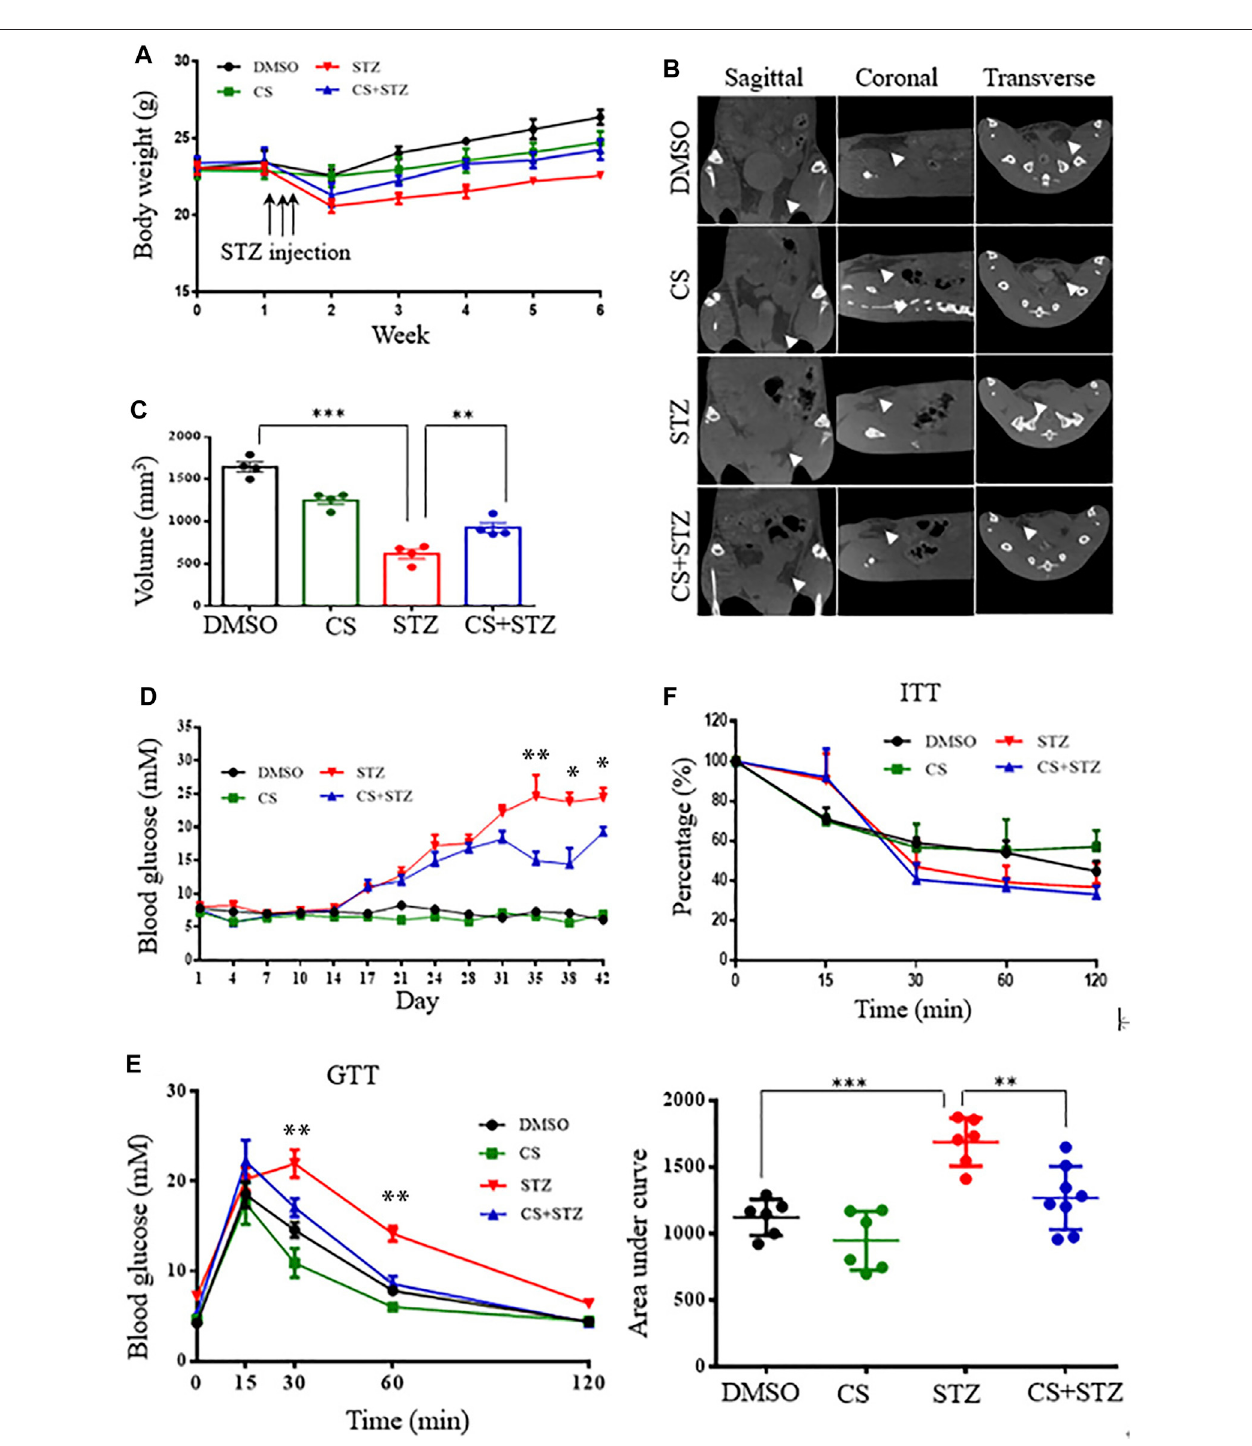
FIGURE2| CSrelievesdiabetesinstreptozotocin(STZ)-treatedmice. Eight-week-old mice weresubcutaneously injected withDMSO orCS(25 mg/kg/dose, two doses daily) for 42 continuous days. Micewere administrated subcutaneously with STZ (40 mg/kg of body weight daily) for four continuous days from the 8th day of the experimental treatment period. (A) Body wight was monitored over time ( n = 7 – 10 mice per group). (B,C) Body fat was measured by micro-computed tomography (B) and adipose tissue volumes between lumbar vertebra one and the caudal vertebra four were compared (C) at the end of the experiment. (D) Blood glucose levels weredeterminedusingaglucometer fromthetailveineverytwootherdays. (E) Glucosetolerancetests(GTT) wereperformedin12-hfastedmice givenintraperitoneally glucose(2 g/kgbodyweight).Plasmaglucoseconcentrationsweremeasuredat thedesignatedtimepoints(leftchart)andtheareasunderthecurve (AUC)ofGTTwere calculated (right chart) ( n = 6 – 8 for each group). (F) Insulin tolerance tests (ITT) were conducted in 6-h fasted mice with an intraperitoneal injection of insulin (1 unit/kg body weight). The percentages are relative variations of plasma glucose concentrations at the designated time points from the time 0 min, which was arbitrarily set as 100% ( n = 8 – 10 mice per group). * p < 0.05, ** p < 0.01, *** p < 0.001.